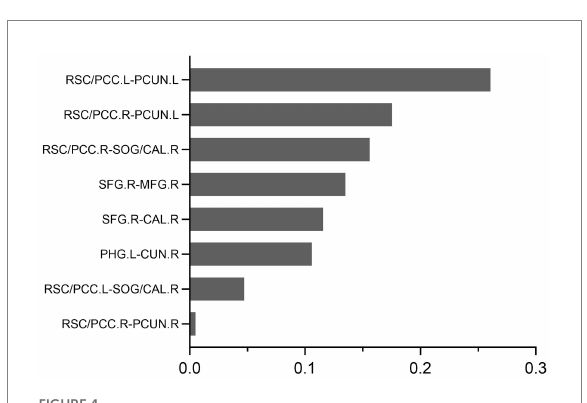
FIGURE 4 The feature weights of the random forest prediction